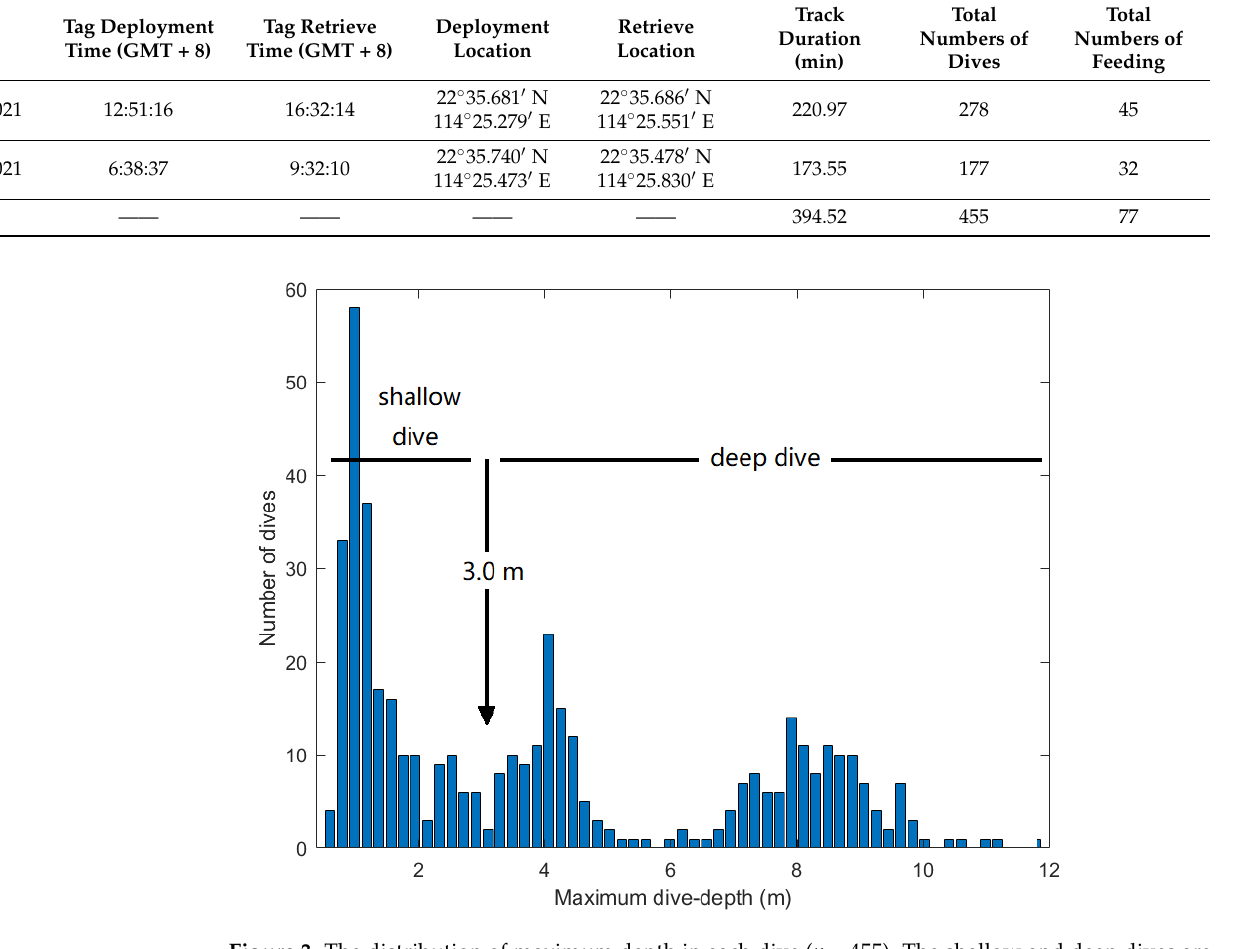
Table 2. Summary of descriptive statistics (mean ± standard deviation) for dive parameters of the Bryd e’s whale on July 2 and 4, 2021.